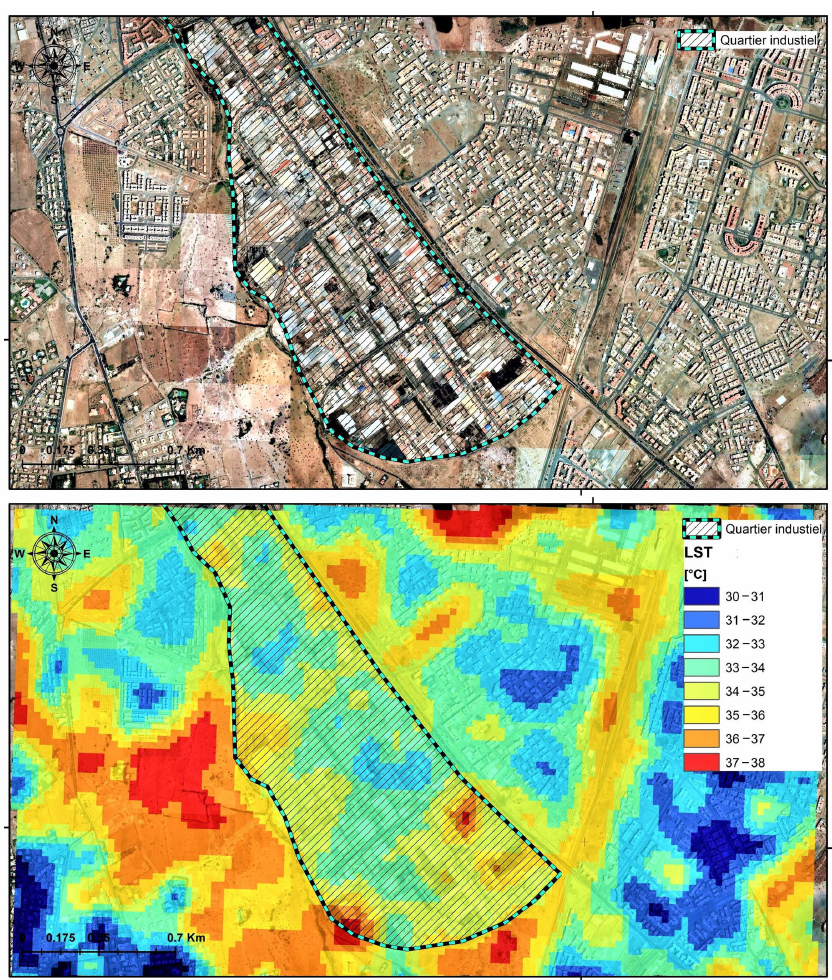
Figure 14. The Quartier Industrial in the Sidi Ghanem district.